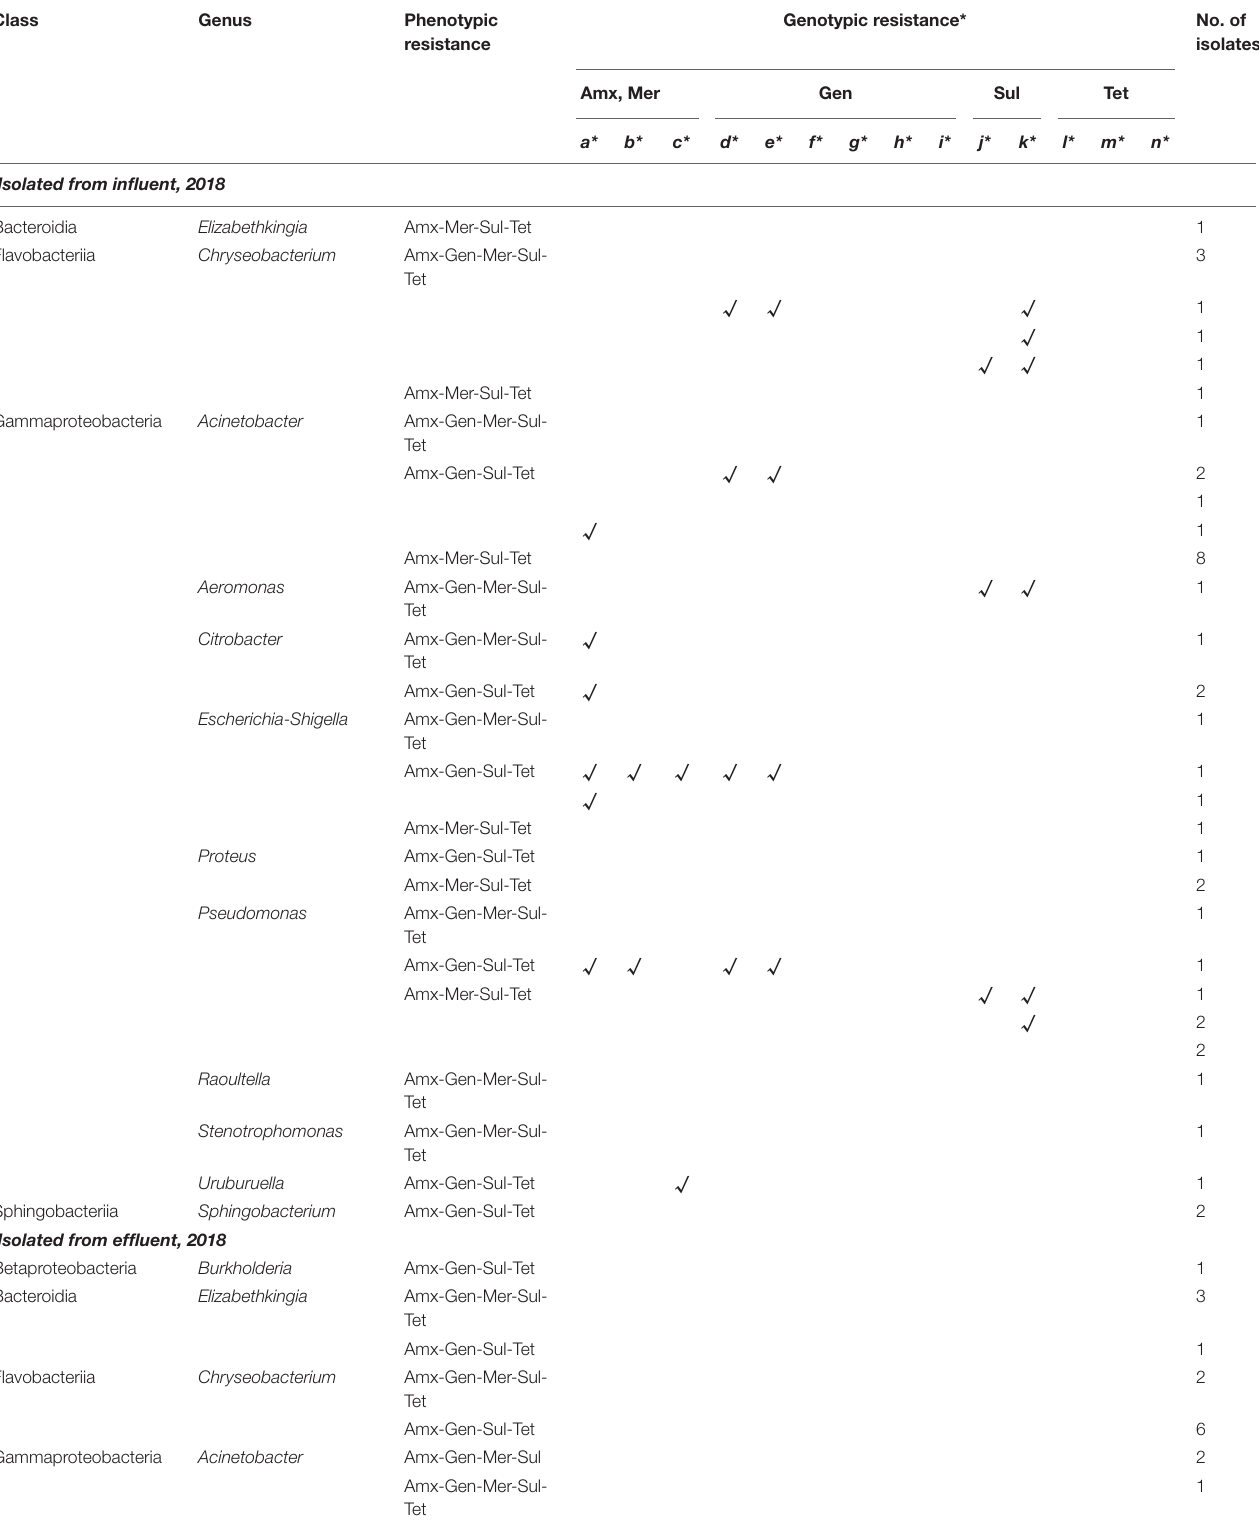
TABLE 2 | Phenotypic and genotypic resistance profile of multidrug-resistant bacteria isolated from JN WWTP in 2018.